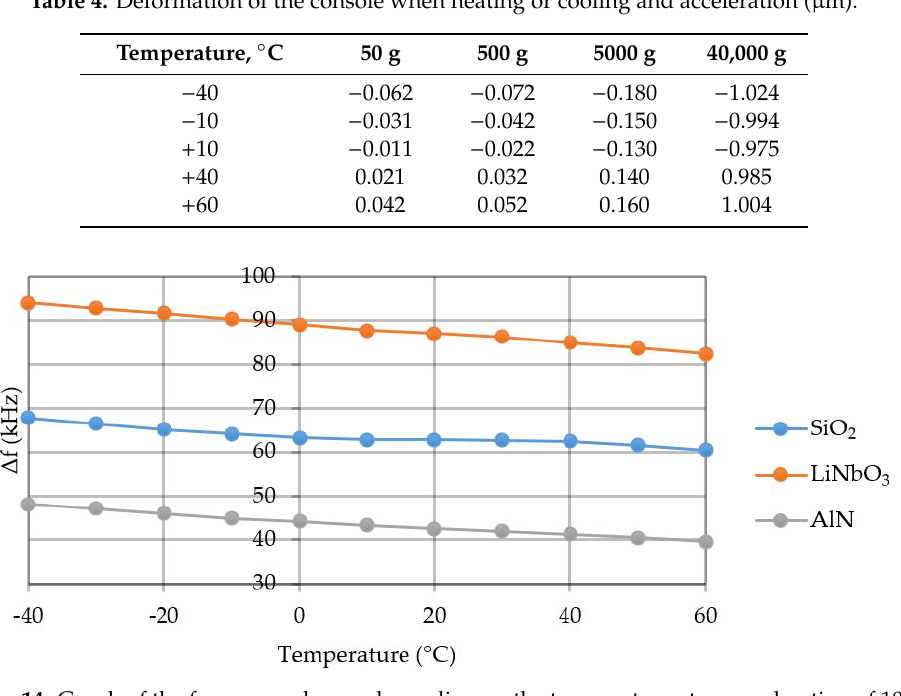
Figure 14. Graph of the frequency change depending on the temperature at an acceleration of 100 g.